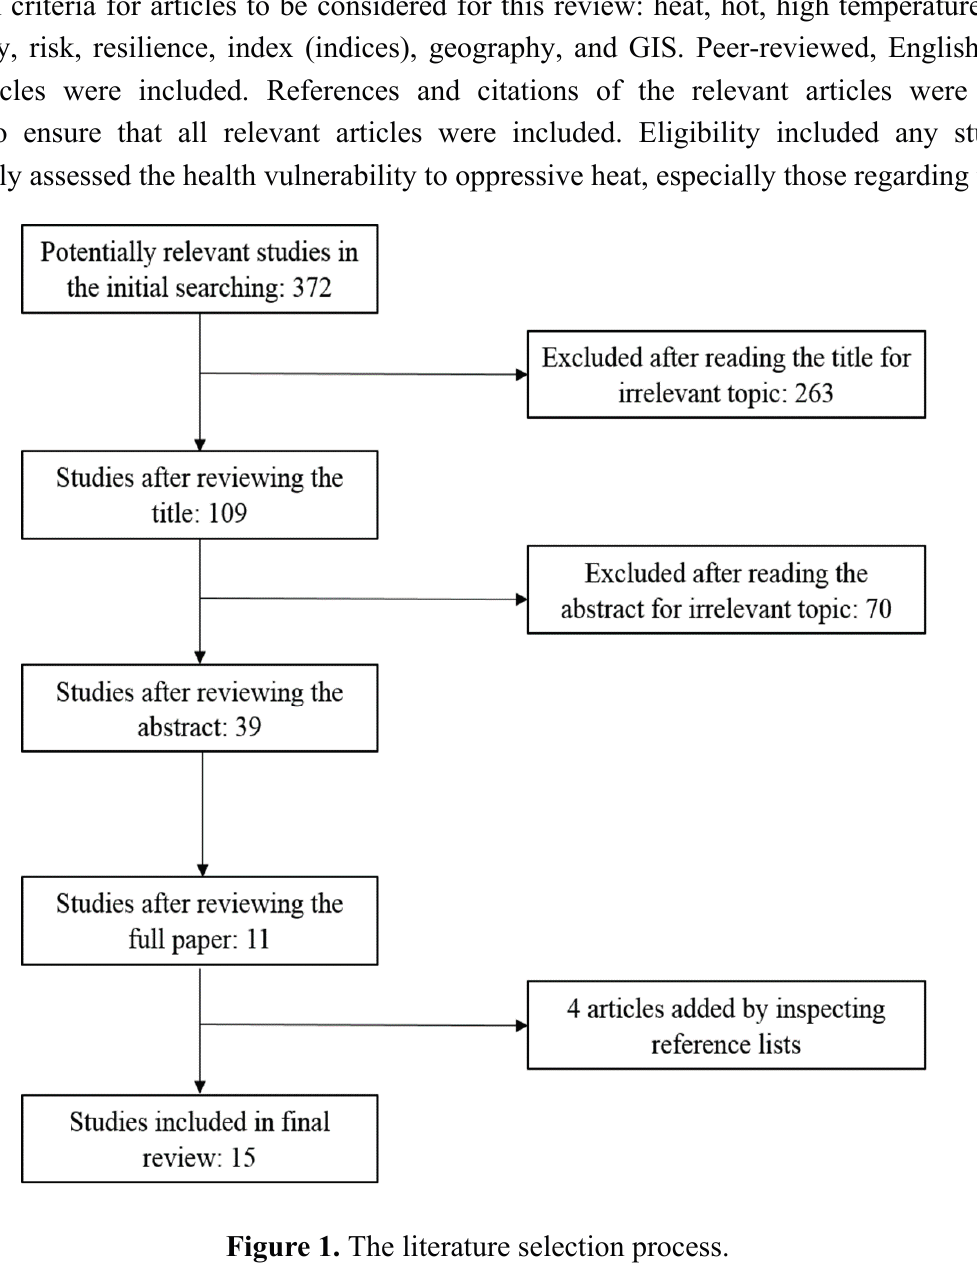
Figure 1. The literature selection